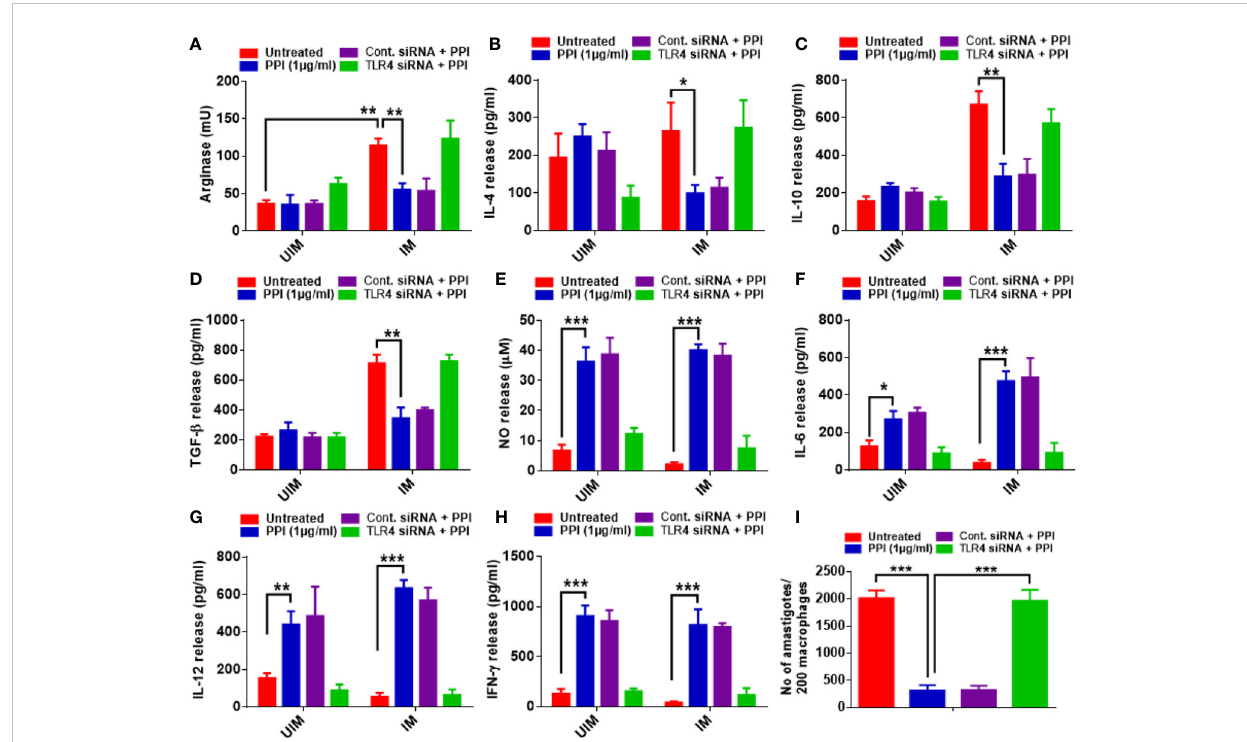
FIGURE 4 TLR4-dependent alteration of M1 – M2 markers and parasite burden in L. donovani -infected macrophages. The macrophages were cultured and transfected with TLR-4 siRNA and were infected with stationary-phase L. donovani promastigotes in a 1:10 (macrophage/parasite) ratio, and after 4 h, the non-ingested parasites were removed by washing with sterile phosphate-buffered saline. After 24 h of infection, the macrophages were treated with or without the protein protease inhibitor (PPI). The supernatant was subjected to ELISA to determine the level of pro-in fl ammatory and anti-in fl ammatory cytokines. Arginase activity (A) , IL-4 (B) , IL-10 (C) , TGF- b (D) , NO (E) , IL-6 (F) , IL-12 (G) , IFN- g (H) , Parasite load in macrophage (I) . The asterisks indicate a signi fi cant difference upon comparing the respective PPI-untreated with the PPI-treated groups. * p ≤ 0.05, ** p ≤ 0.01, and *** p ≤